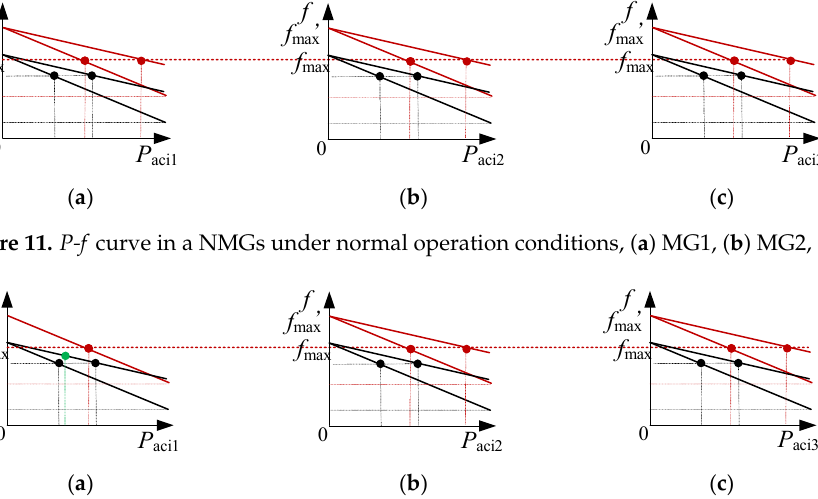
Figure 12. P-f curve in a NMGs under the communication failure of DER11 in MG1, ( a ) MG1, ( b ) MG2, ( c ) MG3.